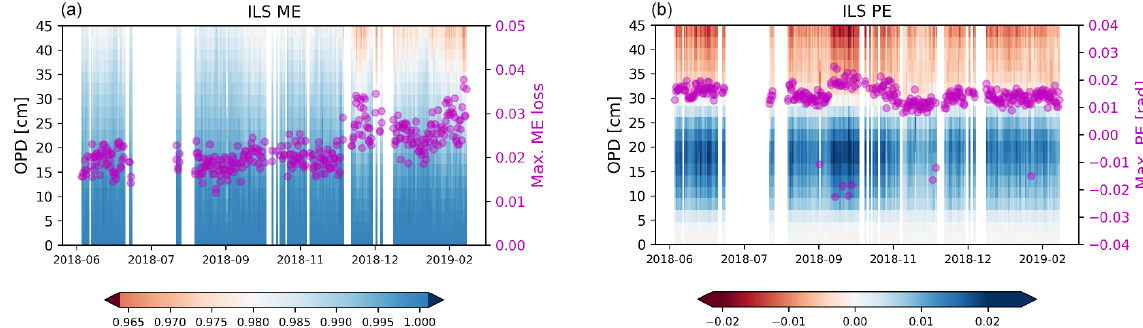
Figure 2. The modulation efficiency (ME, a ) and phase error (PE, b ) along the optical path difference (OPD) at Xianghe. The purple dots are the maximum ME loss (a) and the maximum PE deviation (b) .